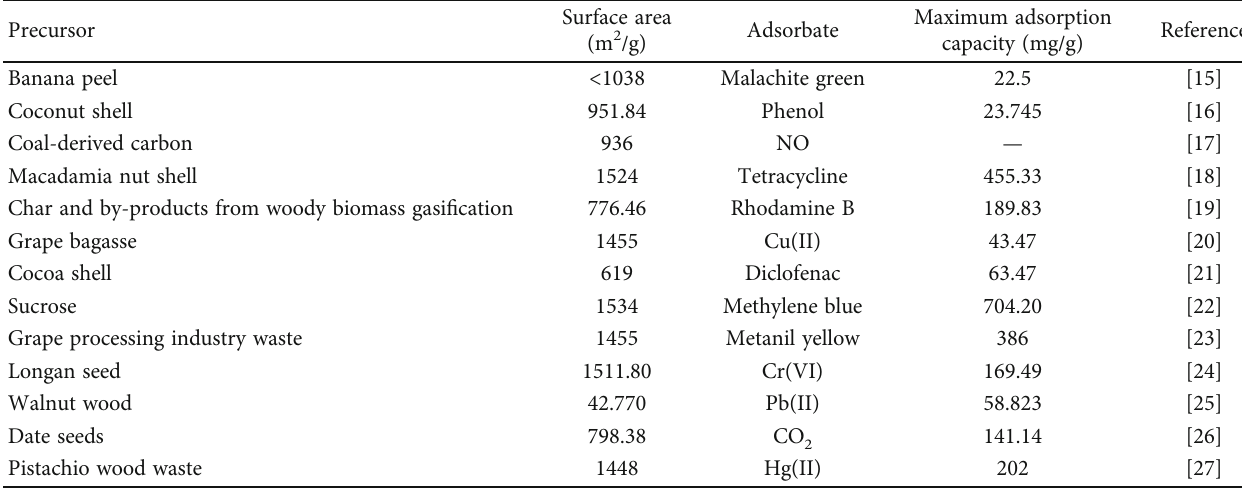
Table 1: Activated carbon precursors utilized for adsorption of various adsorbates.